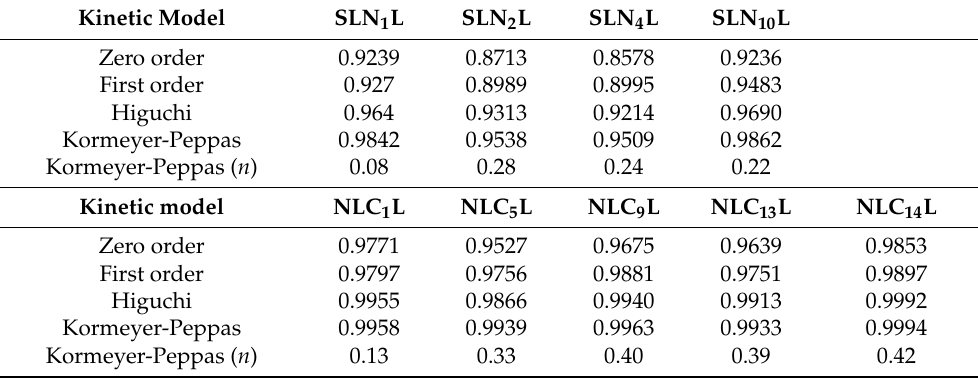
Table 4. Correlation coefficients (R 2 ) and release exponent ( n ) values obtained from the different kinetic models for SLNs (upper) and NLCs (down)